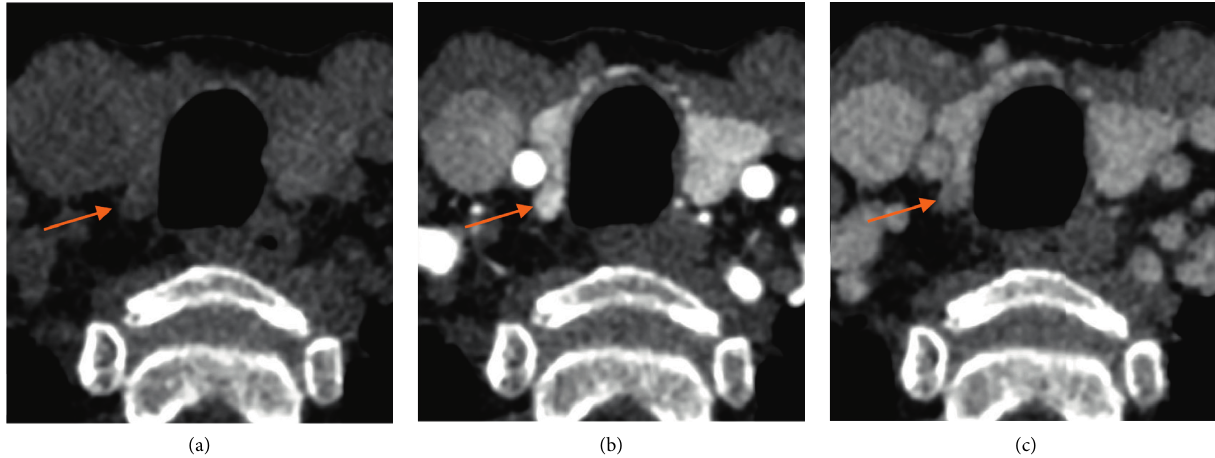
Figure 3: 4DCTof a small right upper parathyroid adenoma. (a) NECTwith lower attenuation (b) Arterial phase with higher enhancement. (c) Venous phase with lower